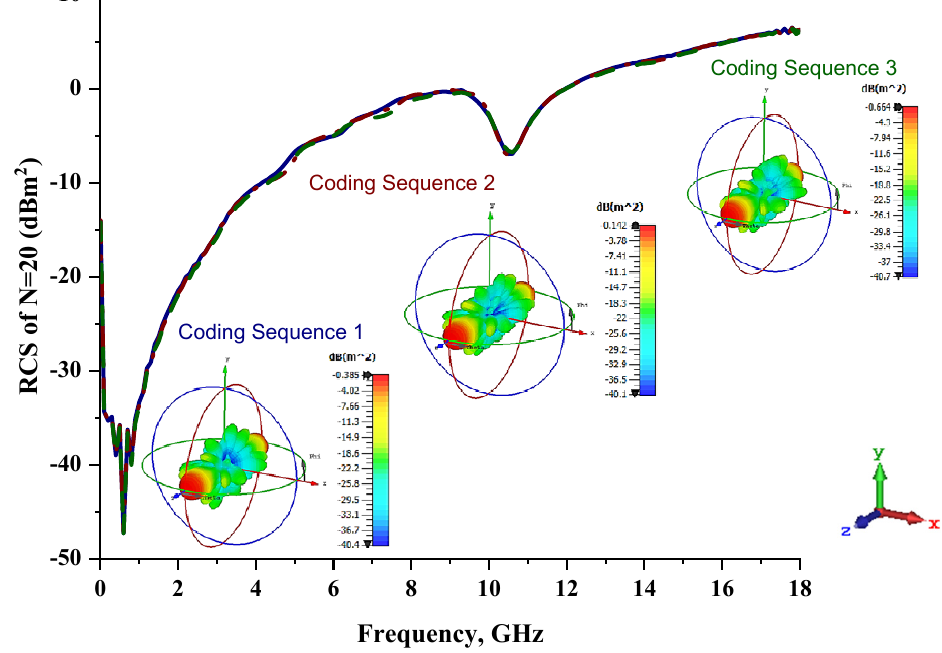
Figure 11. Monostatic RCS and bistatic scattering patterns at 8 GHz for three different coding metamaterials with 20 lattices.